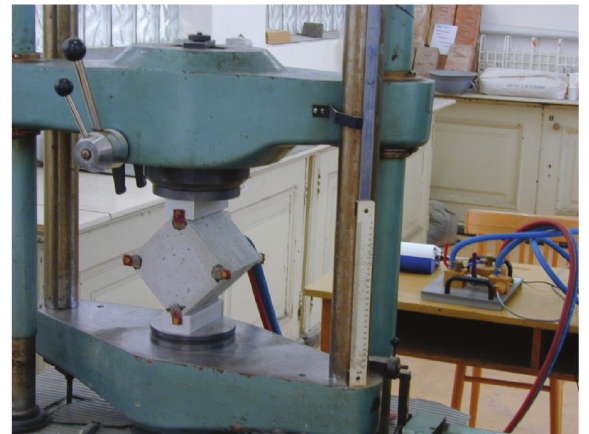
Fig. 3. Splitting tensile strength test in hydraulic press machine with a range of 40 tons